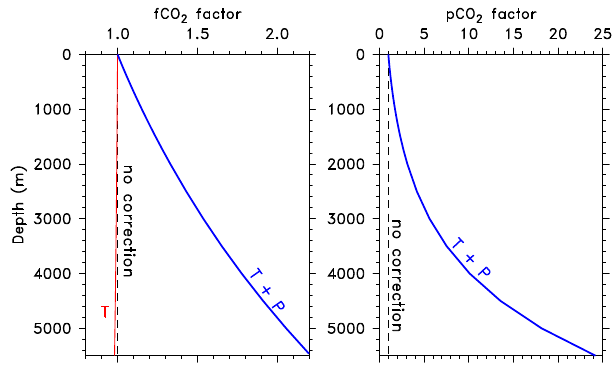
Figure 1. Effect of pressure on K 0 and C f given as factors that would need to be multiplied by (left) f CO 2 and (right) p CO 2 computed without pressure corrections. The reference lines (black dashed) are the pseudo-potential values computed from surface P and in situ T, the potential values (red) are computed from surface P and potential T, and the in situ values (blue) are computed from total P and in situ T. These global-mean vertical profiles were com- puted with mocsy 2.0 and the GLODAP–WOA2009 gridded input